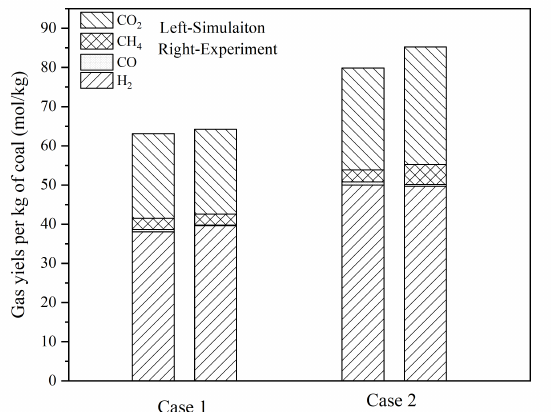
Figure 2. Comparison of the experimental and simulated gas productions.